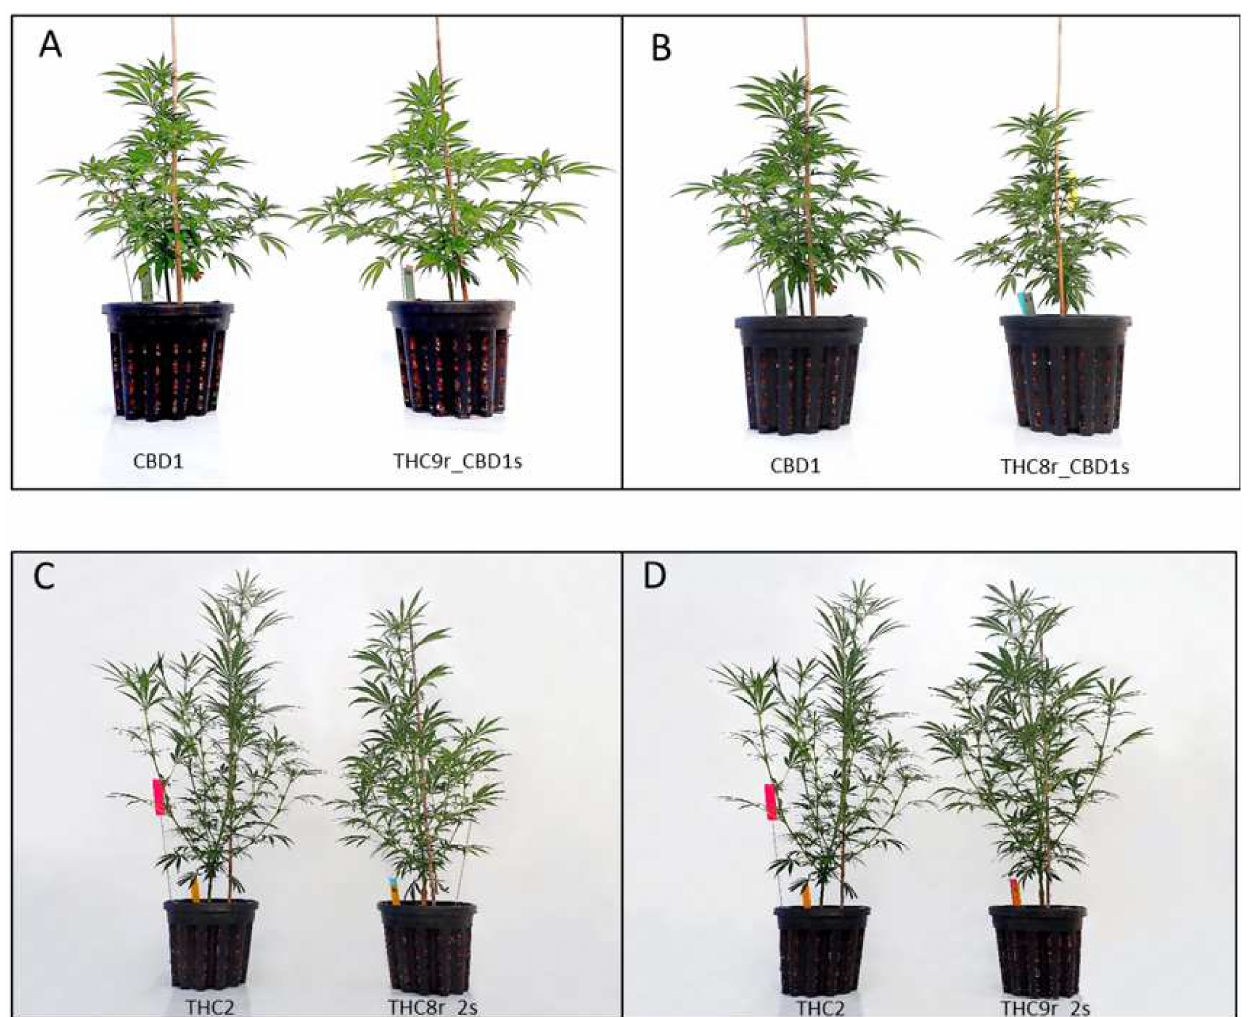
Figure 4. ( A , B ): Photograph of the ungrafted CBD1 plants next to the grafted THC9r_CBD1s and THC8r_CBD1s. ( C , D ): The THC2 ungrafted plants next to the grafted THC8r_2s and THC9r_CBD2s. Plants were selected based on being closets to the median value for